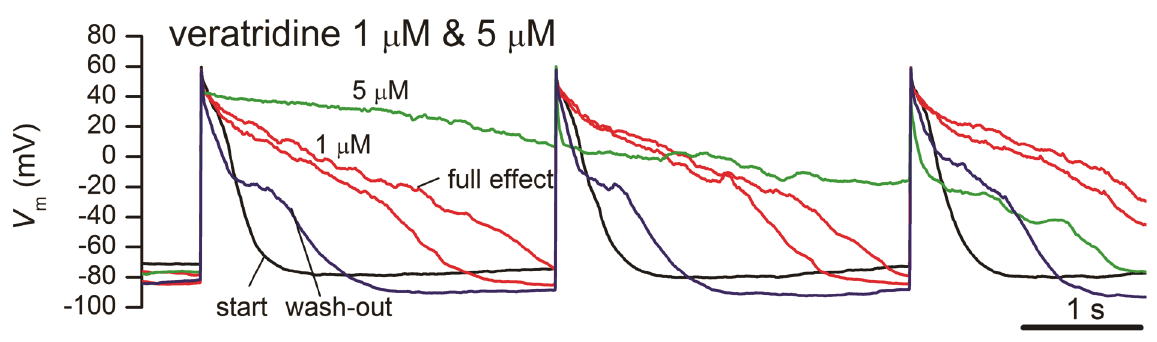
Figure 4. AP prolongation by veratridine in human iPSC-derived cardiomyocytes. Current-clamp AP recordings using a pacing protocol with injected current stimuli of 0.5-ms duration and 2 nA amplitude repeated at 3-s intervals. The overlap of traces in control conditions at the start of the experiment, with 1 μM veratridine (onset and full effect), with 5 μM veratridine, and during wash-out, shows partial recovery.